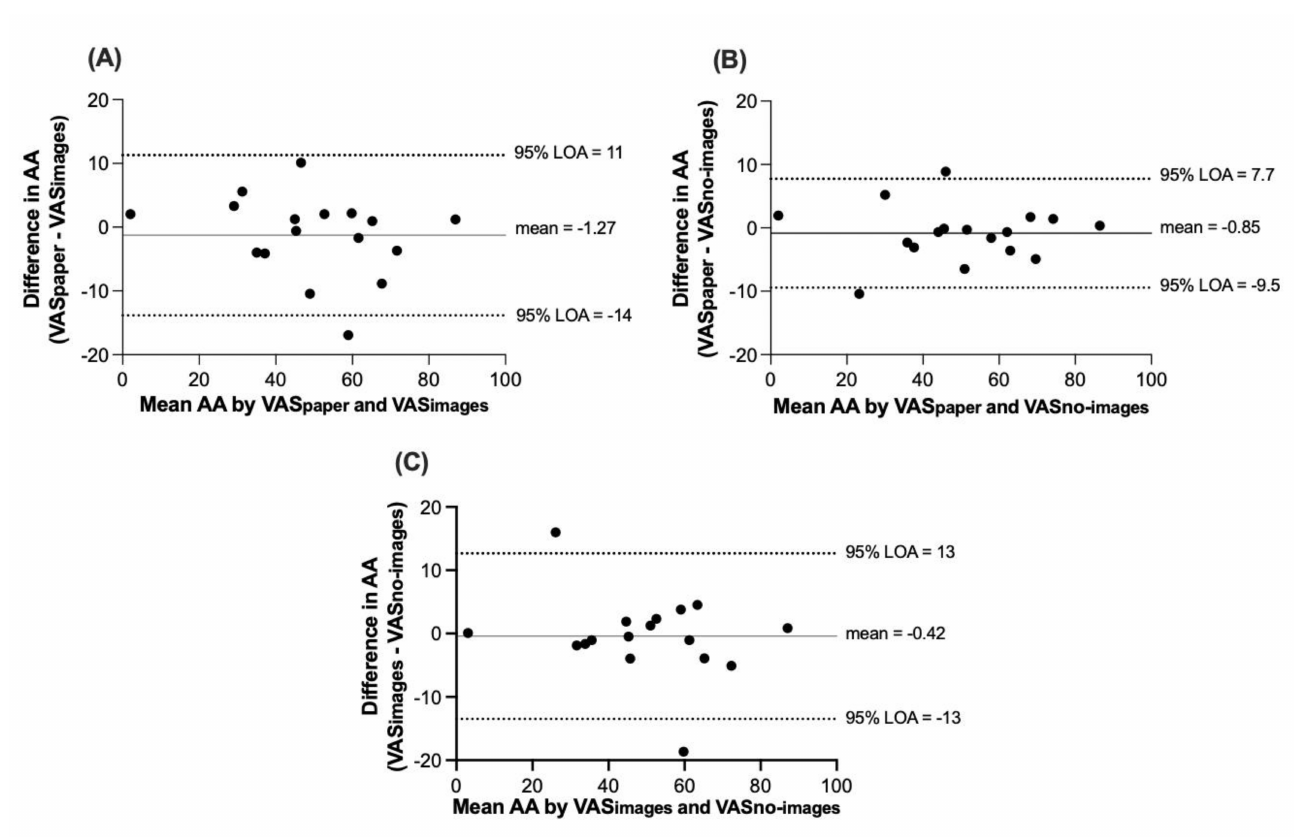
Figure 2. ( A ) Bland–Altman plots (95% limits of agreement) of the difference in VAS paper and VAS images (units) versus the mean of VAS paper and VAS images for average appetite (AA) immediately before the ad libitum lunch (35 min). The same comparison is made for ( B ) VAS paper and VAS no-images and for ( C ) VAS images and VAS no-images . n =